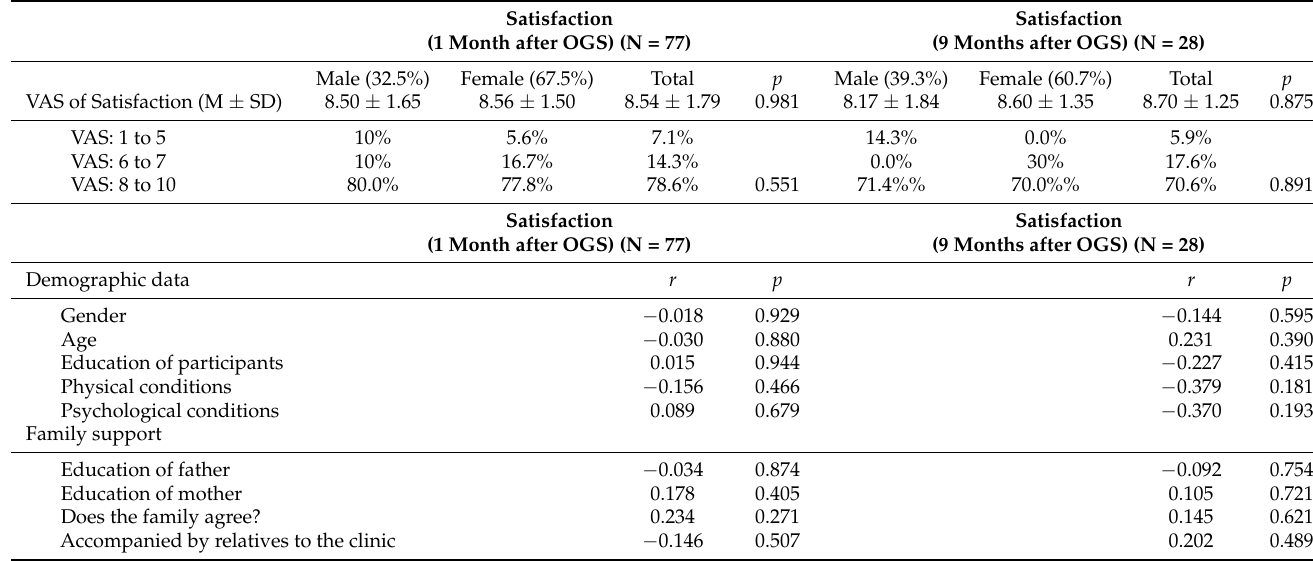
Table 1. Surgical satisfaction of OGS and its correlation with demographic data and family support.